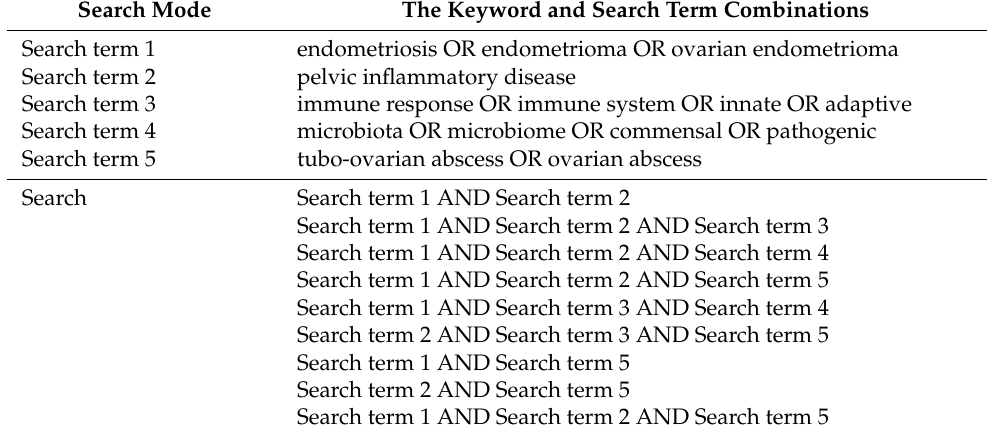
Table 1. The search